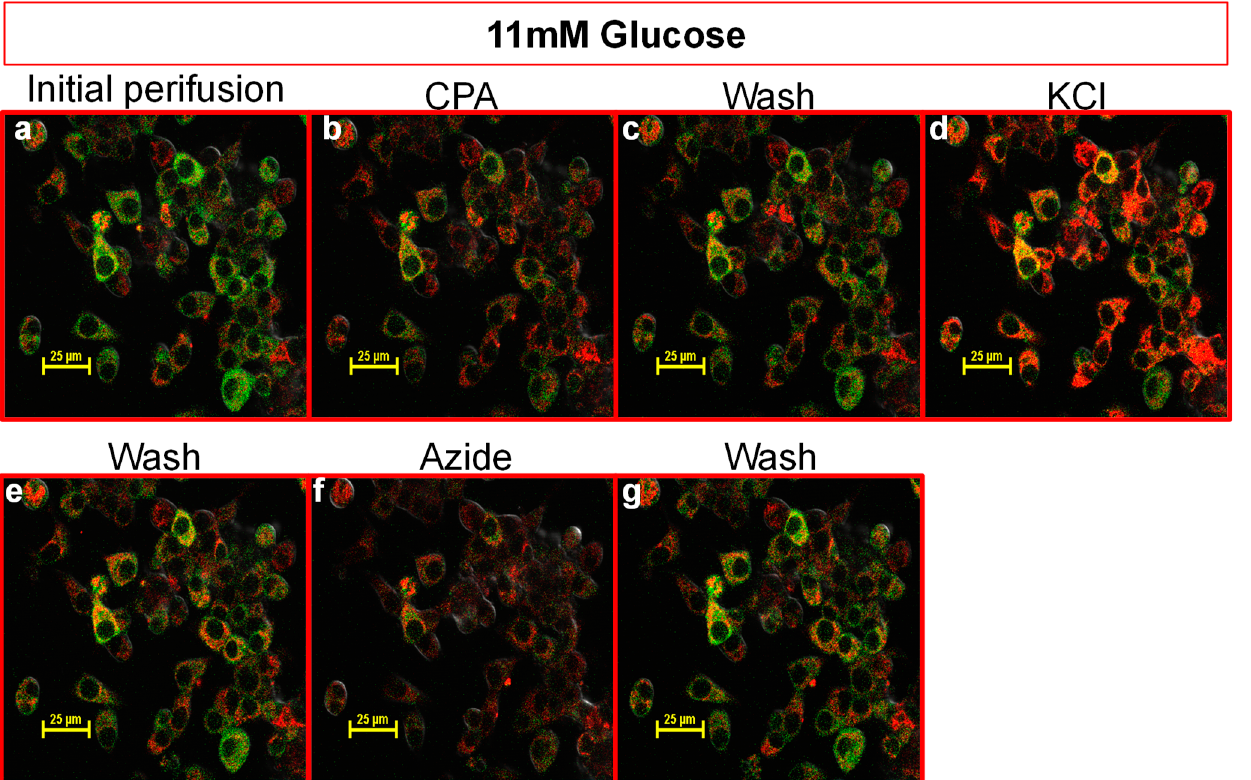
Figure 2. Functional characterization of DS-1 transduced INS1-832/13 cells with agents known to affect ER and mito Ca 2+ . Cells were initially treated with imaging buffer and exchanged with specific agents dissolved in imaging buffer. Live cell images were taken continuously every 10 s during the process. ( a – g ) Snapshot of confocal image for each treatment condition and washes. The complete time series is shown in Movie S1. ( h , j ) Mean ER and mito fluorescent value of all the cells in the field with their standard deviation. The arbitrary fluorescent value of each cell is calculated from ImageJ. ( i , k ) Quantitation of change in fluorescence represented as normalized AUC (area under curve) rel- ative to 11 mM glucose (imaging buffer) for each treatment condition and their statistical summary.